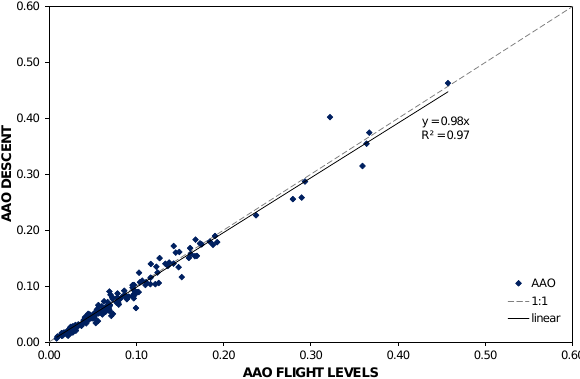
Fig. 16. Comparison of AAO aircraft calculated scattering optical depth adjusted to ambient RH for all the descent data with AAO scattering optical depth adjusted to ambient RH for the fixed sam- pling layers (at